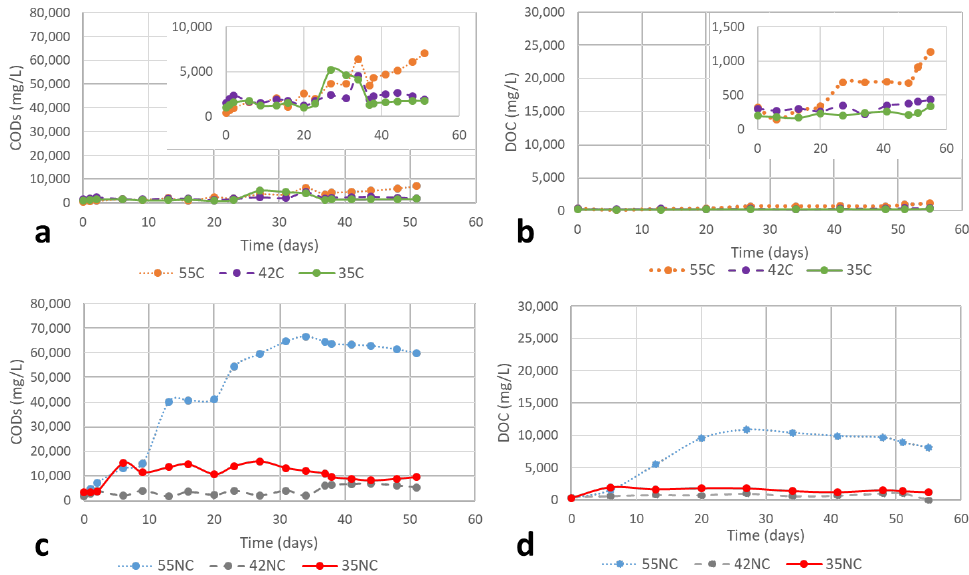
Figure 4. Evolution of organic matter solubilisation at thermophilic (55 °C), intermediate (42 °C) and and mesophilic (35 ◦ C) temperature regimes: ( a ) COD s from chrome-tanned (C); ( b ) DOC from mesophilic (35 °C) temperature regimes: ( a ) COD s from chrome-tanned (C); ( b ) COD s from chro- chrome-tanned (C); ( c ) COD s from chromium-free (NC); and ( d ) DOC from chromium-free (NC) mium-free (NC); ( c ) DOC from chrome-tanned (C); and ( d ) DOC from chromium-free (NC) leather leather shavings.